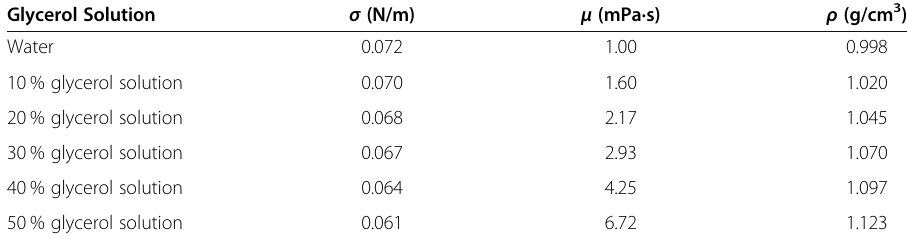
Table 3 Physical properties of glycerol solution at 1 atm and 20°C [34] Glycerol Solution